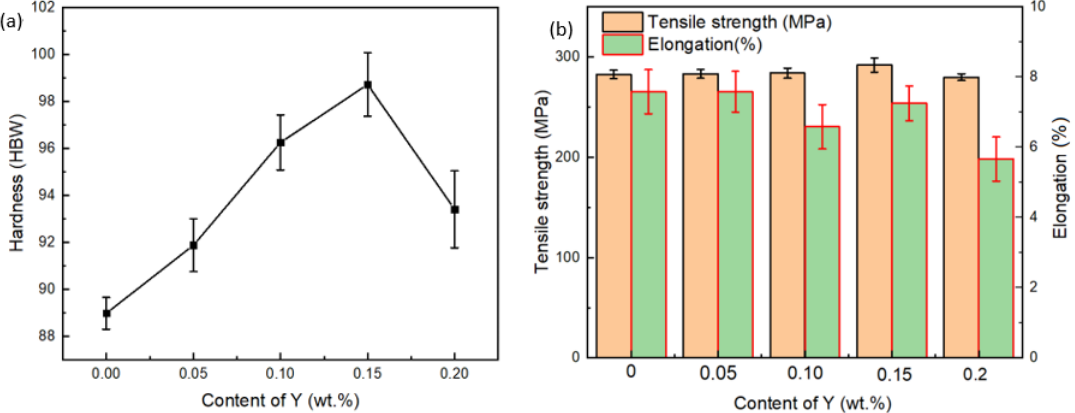
Figure 2. Evolution of ( a ) hardness and ( b ) tensile strength and elongation with increasing content of Y.